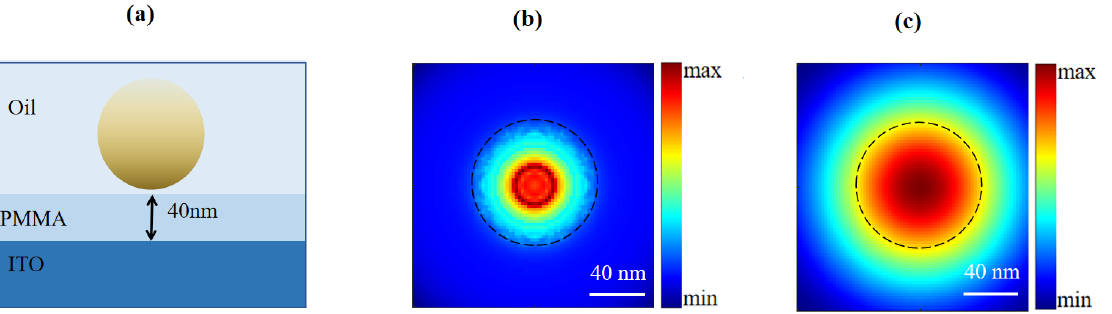
Figure 4. ( a ) The sample of a single nanosphere immersed in oil medium on an ITO glass substrate. ( b ) The corresponding partial LDOS along the longitudinal direction. ( c ) The calculated confocal image.